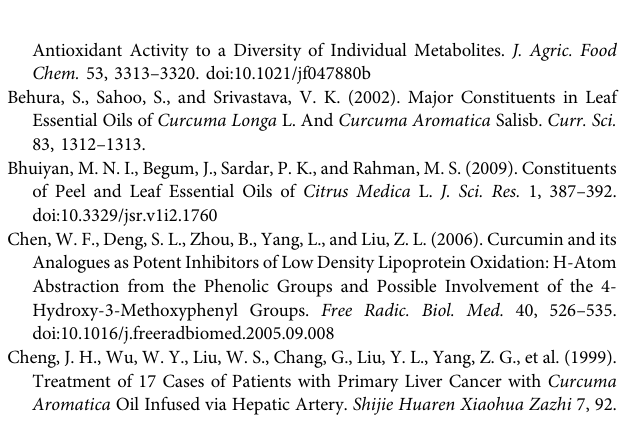
Supplementary Table 5 | The list of 80 compounds identi fi ed by GCMS analysis. Supplementary Table 6 | The list of 62 compounds identi fi ed by LCMS